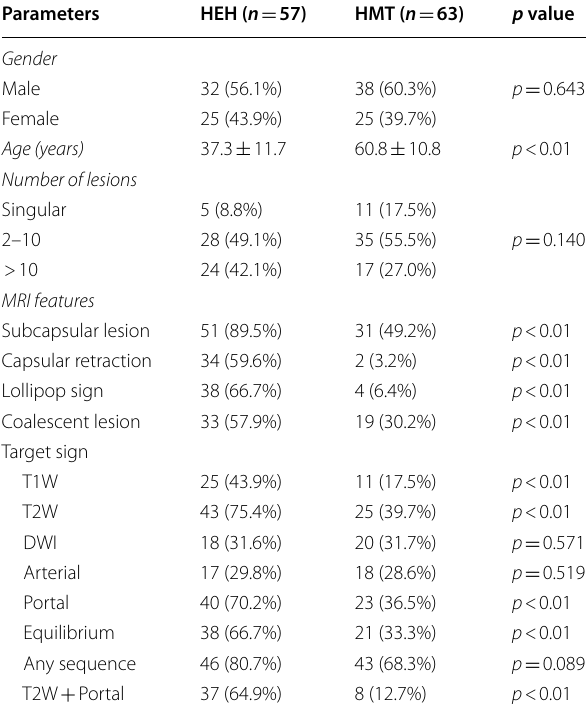
Table 3 Comparison of MRI features between HEH and